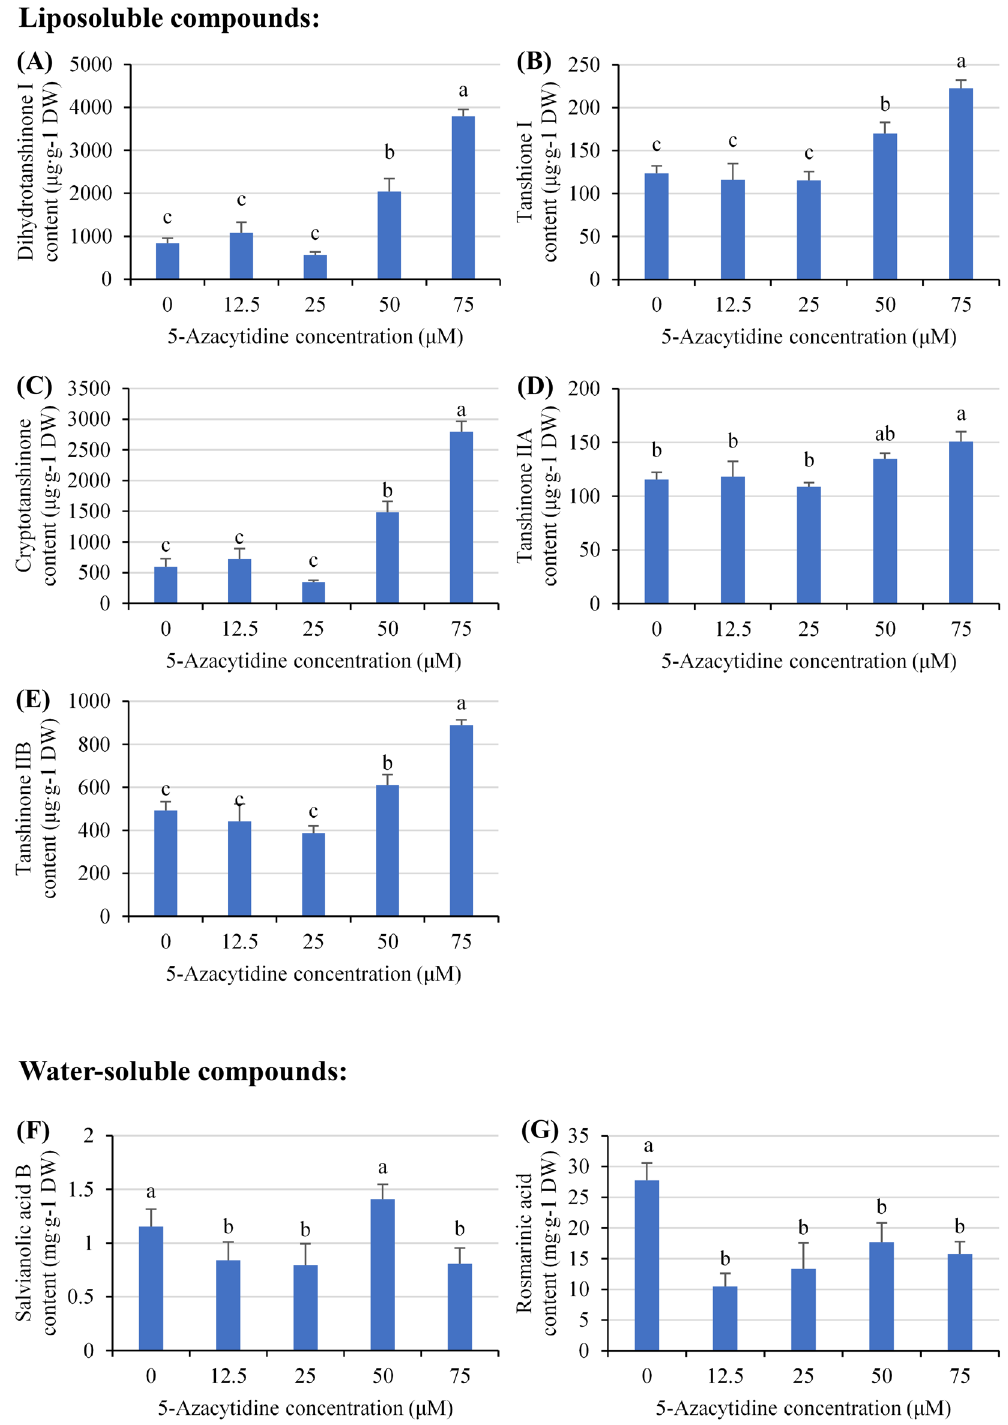
Figure 2. Contents of ( A ) dihydrotanshinone I, ( B ) tanshinone I, ( C ) cryptotanshinone, ( D ) tanshinone IIA, ( E ) tanshinone IIB, ( F ) rosmarinic acid, and ( G ) salvianolic acid B under different levels of 5-azacytidine in Salvia miltiorrhiza hairy root cultures after 28 days. The values are the mean of at least three replicates ± S.E. Different letters indicate significant differences at the 5% level according to the LSD